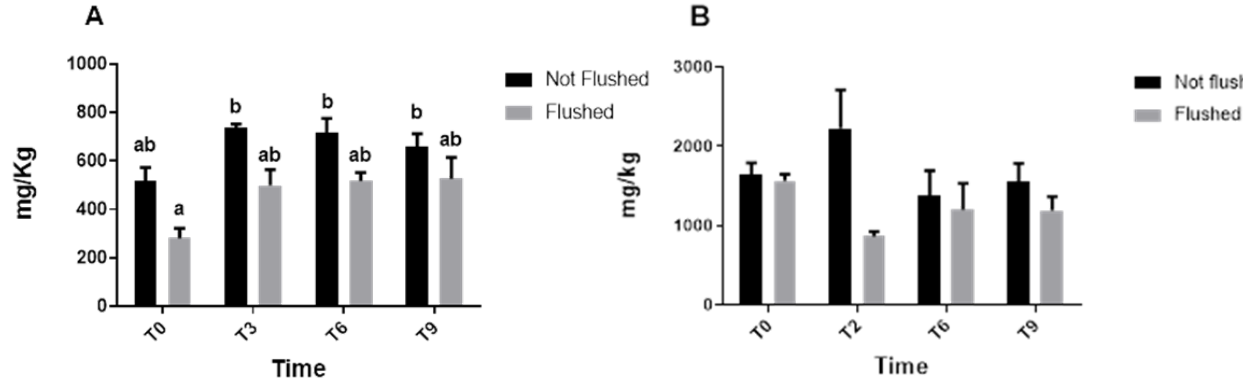
Figure 1. ( A ) Nitrate content measured in Lactuca sativa at harvest and three, six and nine days after harvest (data are mean ± SE, n = 4). ( B ) Nitrate content measured in Eruca sativa at harvest and two, six and nine days after harvest (data are mean ± SE, n = 4). Different letters represent significant differences ( p ≤ 0.05) among treatments and time points, calculated from a two-way ANOVA followed by Sidak’s test.